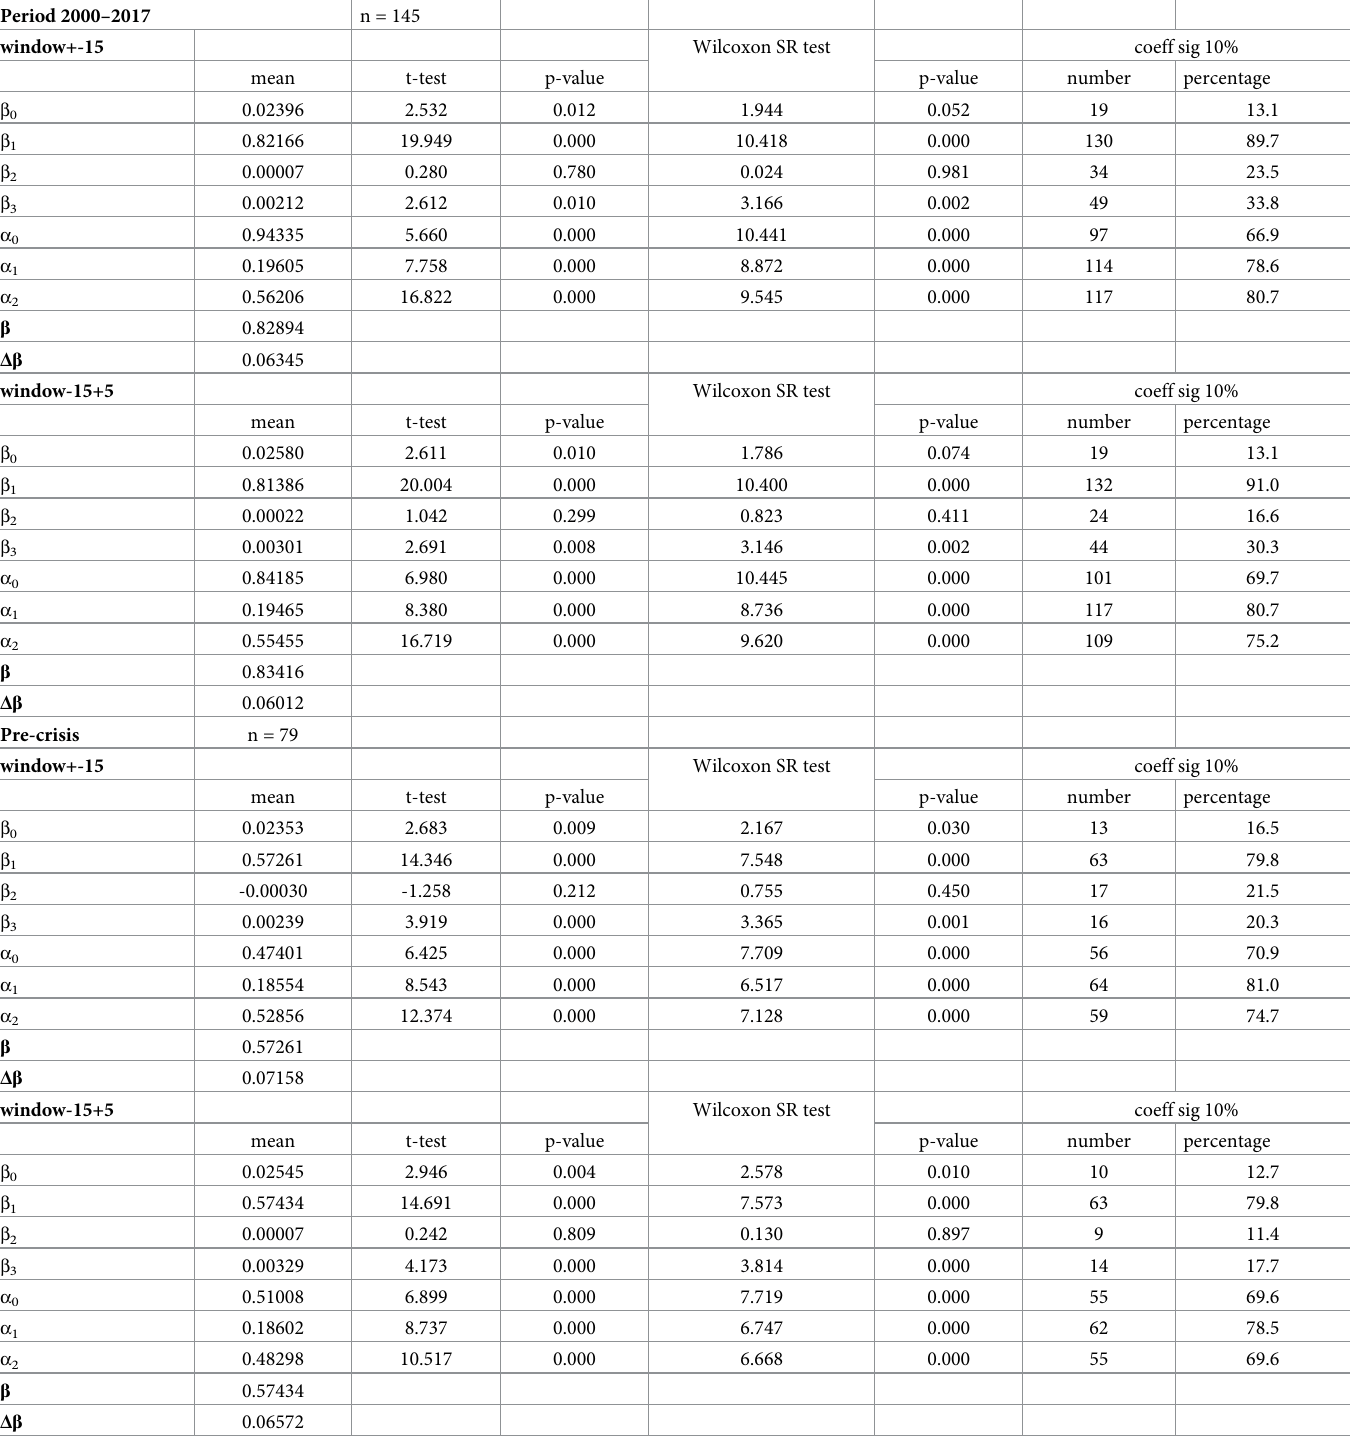
Table 9. Summary results: